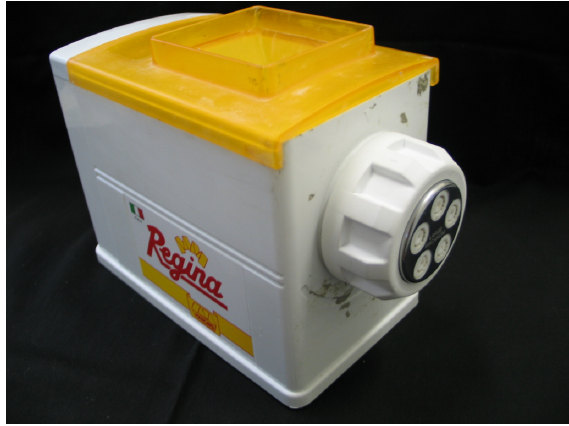
Figure 1. The extruder used for manufacturing bucatini and maccheroni